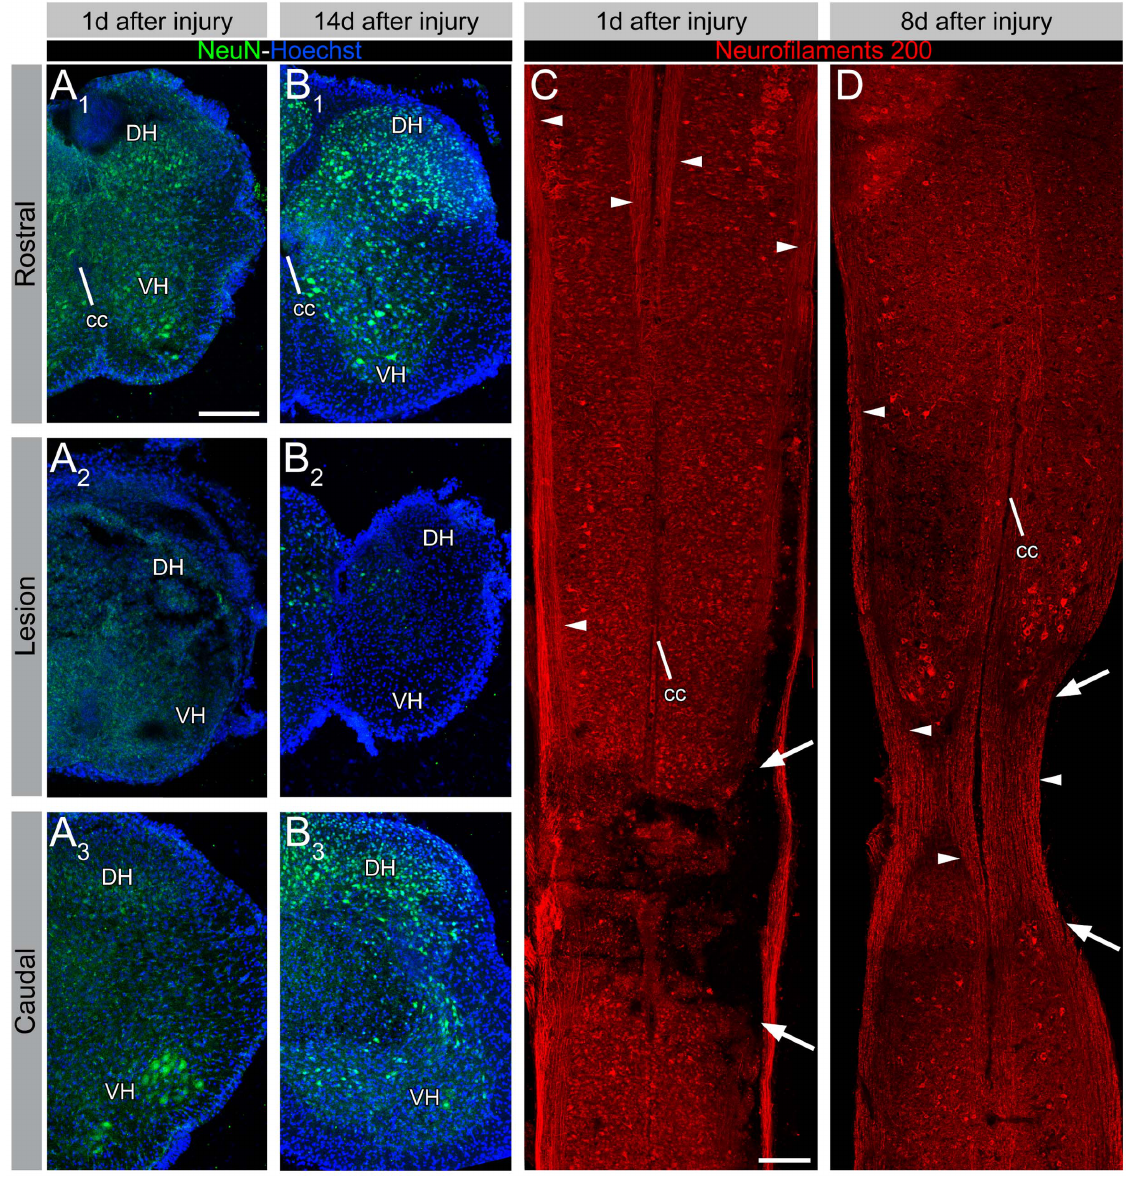
Figure 2. Cellular damage after SCC assessed by immunohistochemistry. (A and B) Immunohistochemistry for NeuN 1 day (A) and 8 days (B) after SCC, seen in transverse sections rostral to, at, and caudal to the lesion. At both timepoints NeuN immunostaining is greatly diminished within the compressed region. (C and D) Immunohistochemistry for 200 kD neurofilaments 1 day (C) and 8 days (D) after SCC, seen in horizontal sections. At 1 day after injury (C) many axons (arrowheads) still traverse the compressed region (arrows), although some fascicles appear to be interrupted. At 8 days after injury (D), there is white matter continuity across the lesion site, with a relatively even density of axons. Abbreviations: cc=central canal, DH=dorsal horn, VH=ventral horn. Scale bars: 200 m